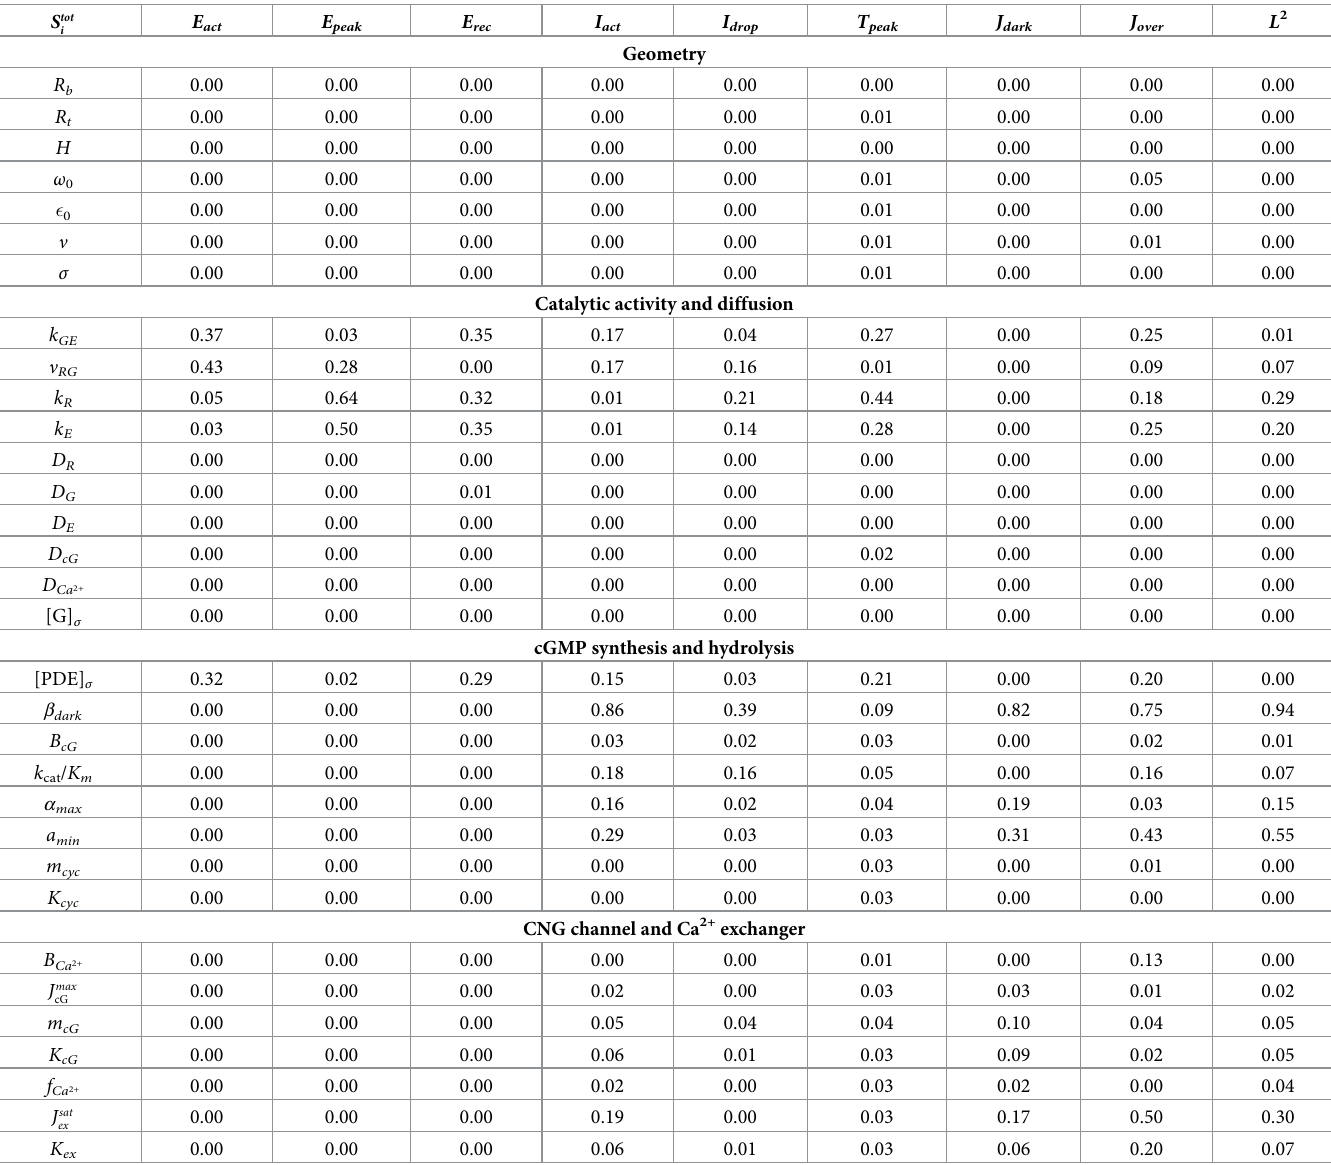
Table 13. Total sensitivity indices. As an index approached 0, the functional became essentially independent of that parameter. A large index value indicated that the con- sidered parameter contributed to significant nonlinear interactions with other model parameters, so that ignoring it would amount to that index’s loss, as a proportion, of the total variance. Some parameters that were negligible, e.g . m , may have been so because their prescribed uncertainties were smaller than other parameters. Confidence cyc intervals are given in S1